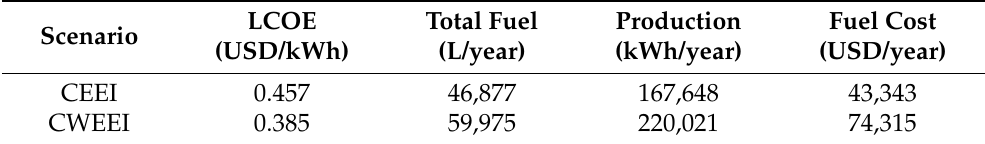
Table 4. Operational and economic values for the CEEI and the CWEEI over the planning horizon with fuel price 0.93 USD/L.